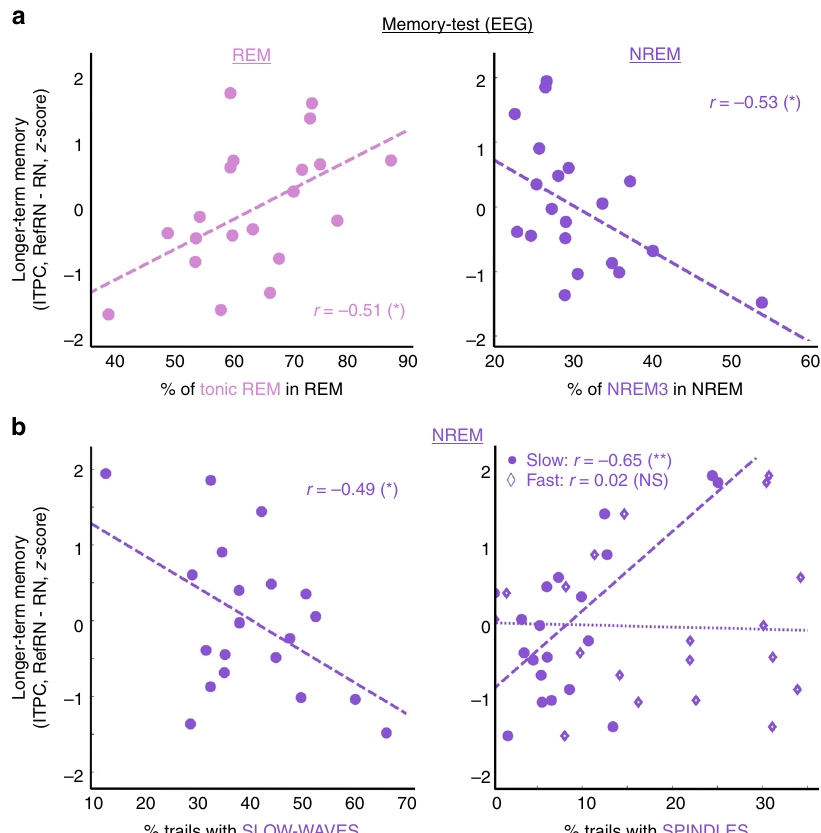
Fig. 6 Impact of prior exposure and sleep rhythms on phase coherence upon awakening. EEG index (Inter-Trial Phase Coherence, ITPC) quantifying longer- term memory (ITPC RefRN — ITPC RN ) for RefRN sounds heard during REM and NREM sleep, computed over the whole post-sleep blocks. a Left: Correlation between the magnitude of the REM sleep EEG index ( z- scored across participants) and the proportion of trials in tonic REM sleep. Right: Correlation between the magnitude of the NREM sleep EEG index and the proportion of NREM3 trials within NREM sleep. As for the behavioral index (Fig. 3b), there was a positive correlation between REM sleep learning and the prevalence of tonic REM sleep. There was also a negative correlation between the marker of learning for the NREM list and the prevalence of NREM3 sleep. b Correlation between the magnitude of the EEG index ( z -scored across participants) for the RefRN heard in NREM and the proportion of trials containing slow waves ( left ) or sleep spindles ( right ; circles: slow spindles; diamonds : fast spindles). Note the negative correlation between the EEG learning index and the proportion of trials associated to slow waves on one hand and the positive correlation with the proportion of trials associated with slow spindles on the other hand. Pearson ’ s correlation coef fi cients are displayed on each correlation plot ( P < 0.01: ** P < 0.05: * P ≥ 0.05, NS) and dotted lines show the linear fi t between the pairs of